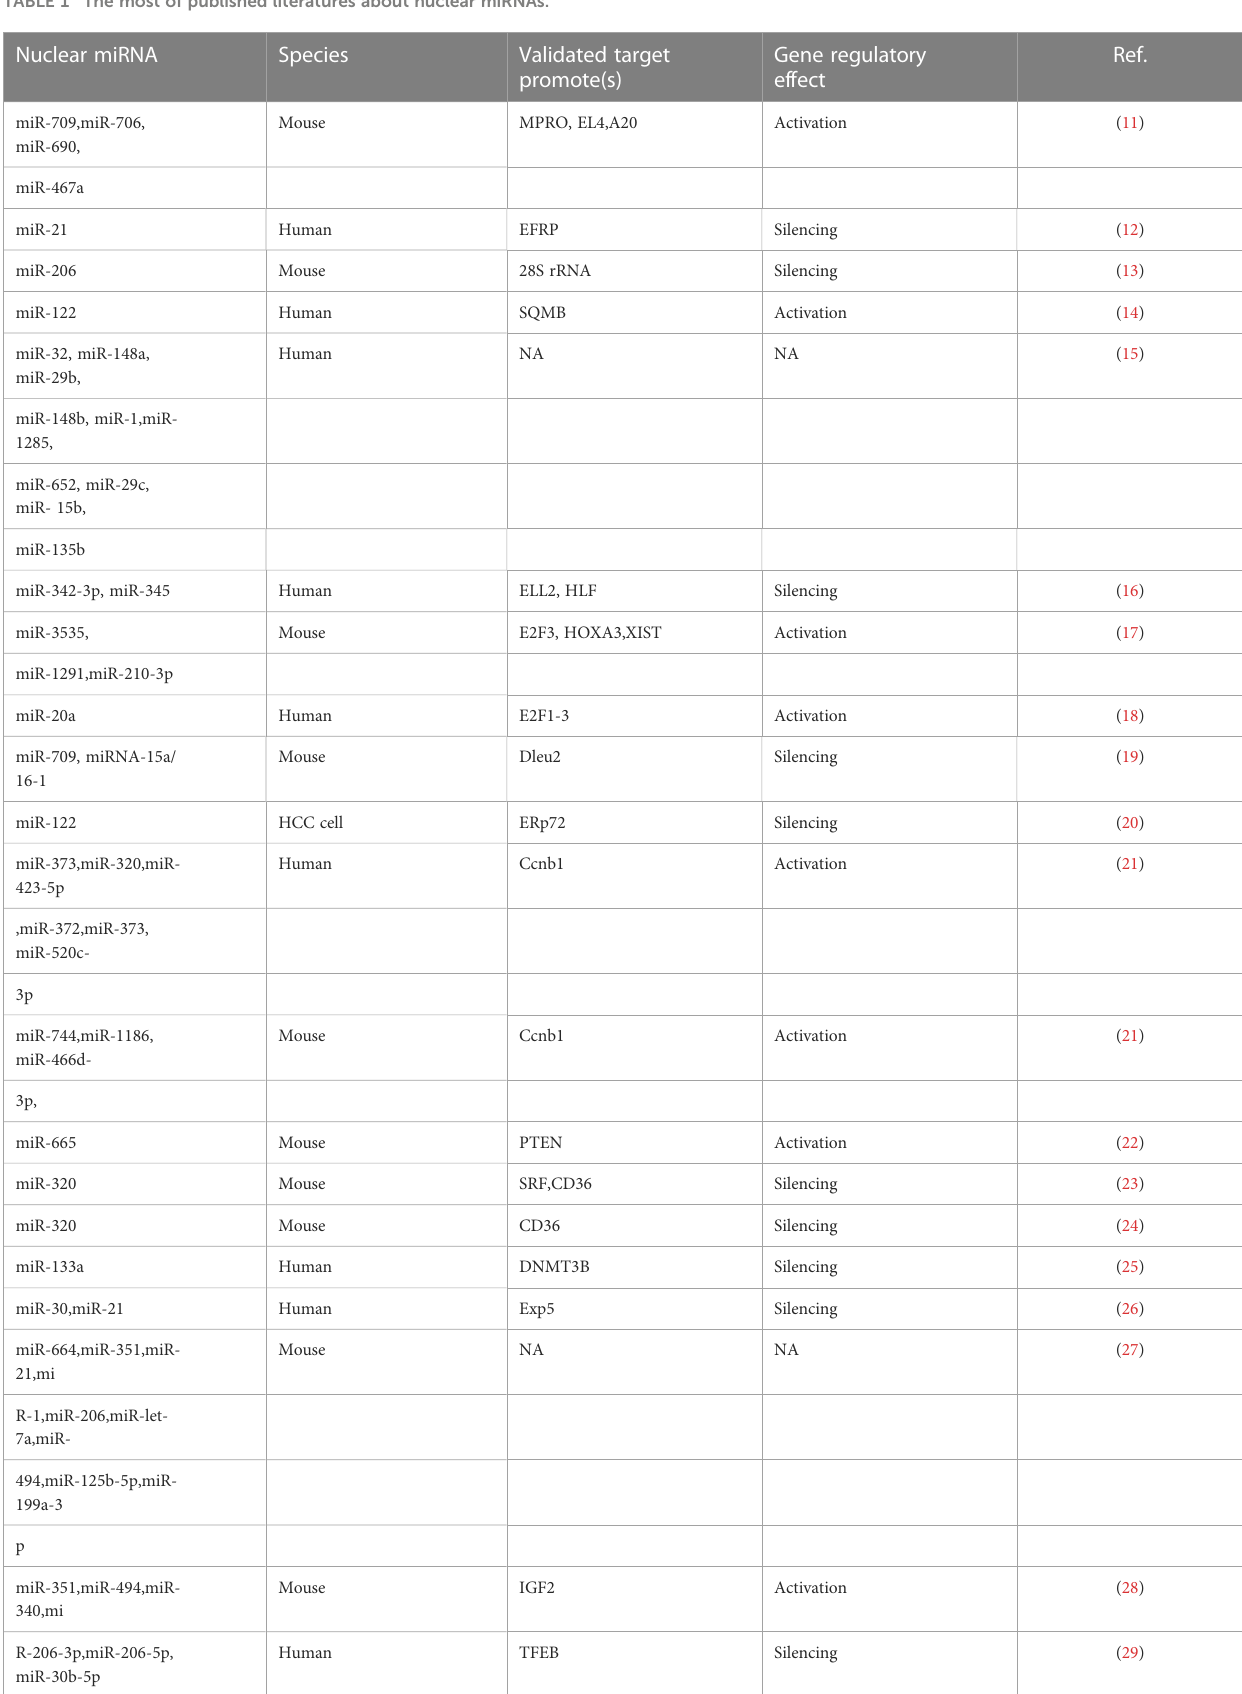
TABLE 1 The most of published literatures about nuclear miRNAs. Nuclear miRNA Species Validated target